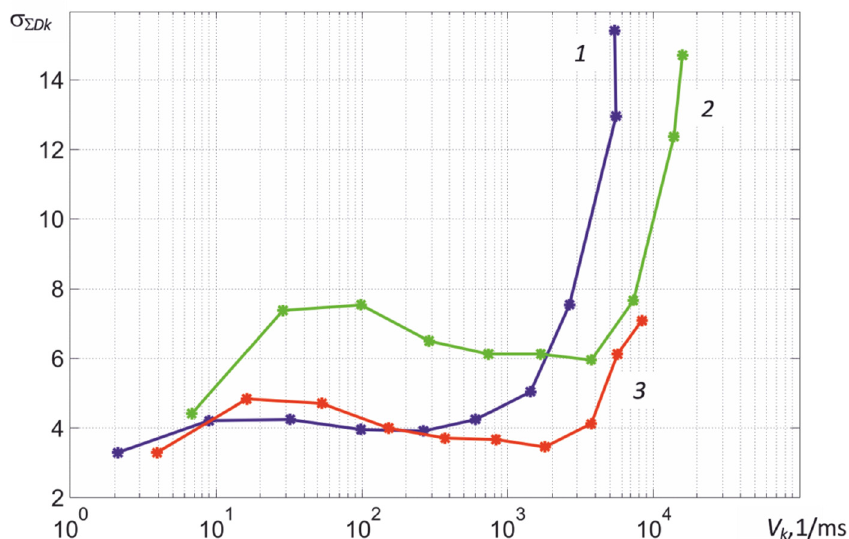
Figure 13. Dependences of the RMS of the total noise of the elements of the MT9V034C12STC matrix of the thermograph camera in ADC readings on the value of the recorded signals V k in the first, second, and third spectral regions at the focal length of the lens f l = 50 mm and the ratio D / f l = 1/16.